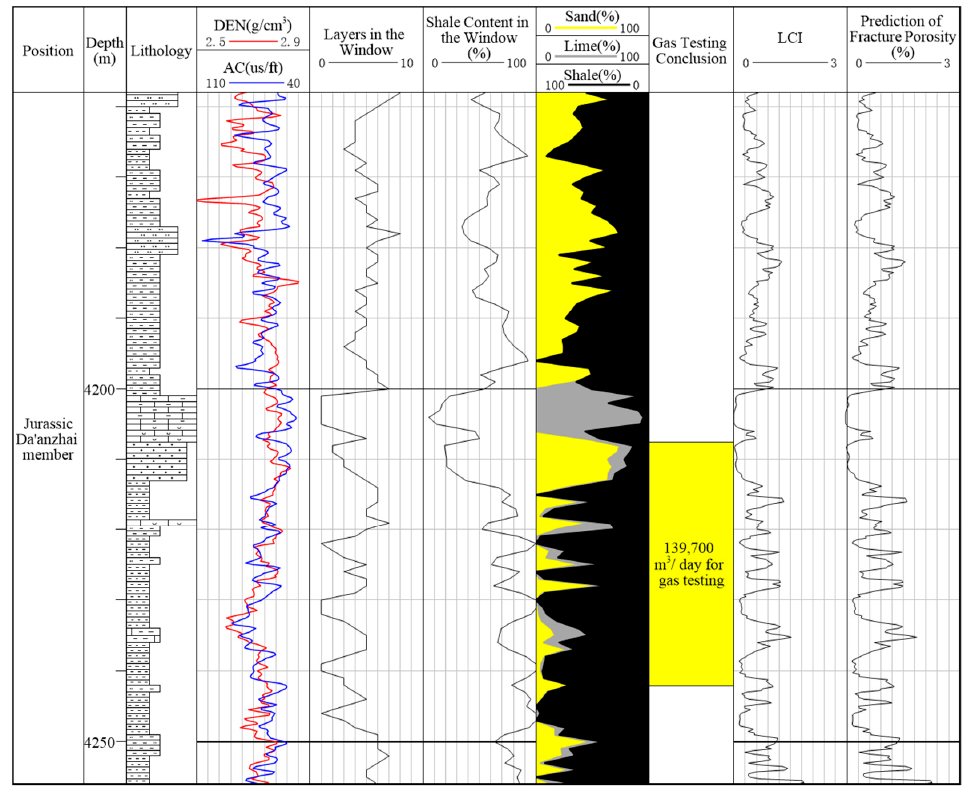
Figure A1. The prediction of fracture in Yuanba 101 well. Minerals 2020 , 10 , x FOR PEER REVIEW